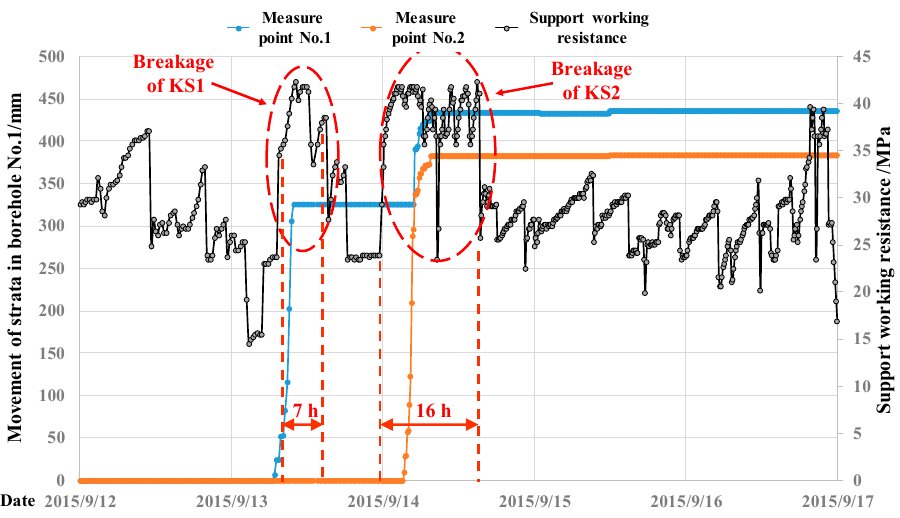
Figure 5. Resistances in No. 55 support along the breakages of key strata KS1 and KS2.